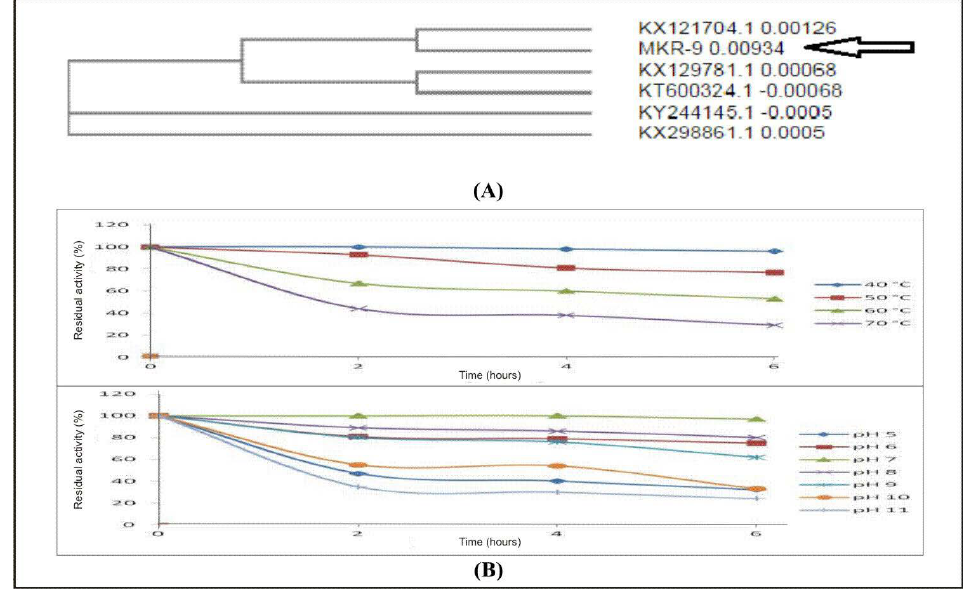
Fig. 1. (A) Phylogenetic tree of MKR-9strain and (B) stability of crude